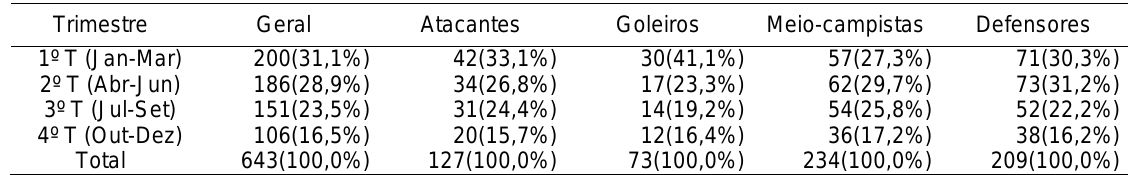
Tabela 3. Frequências geral e por estatuto posicional das datas de nascimento dos jogadores pelos quatro trimestres do